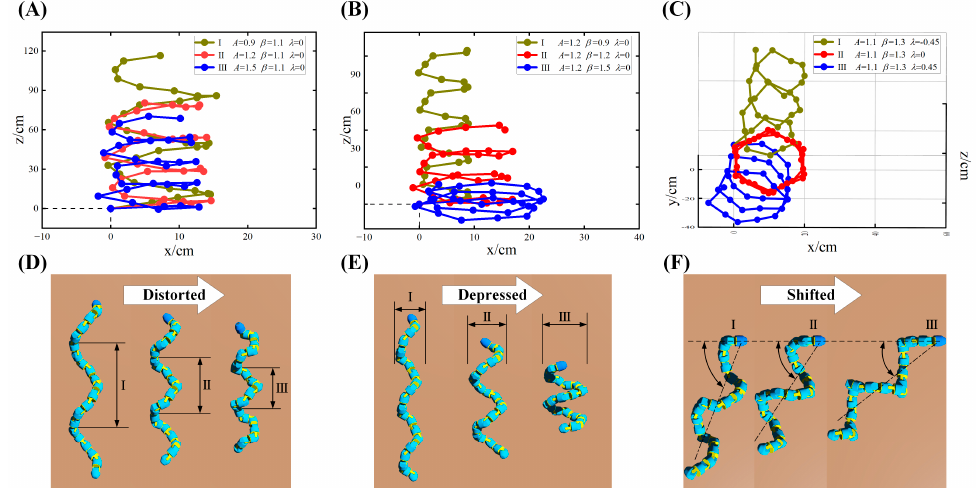
Figure 3. Different spiral climbing gaits when changing the parameters: ( A , D ) the effect of A on spiral climbing gait; ( B , E ) the effect of β on spiral climbing gait; ( C , F ) the effect of λ on spiral climbing gait.